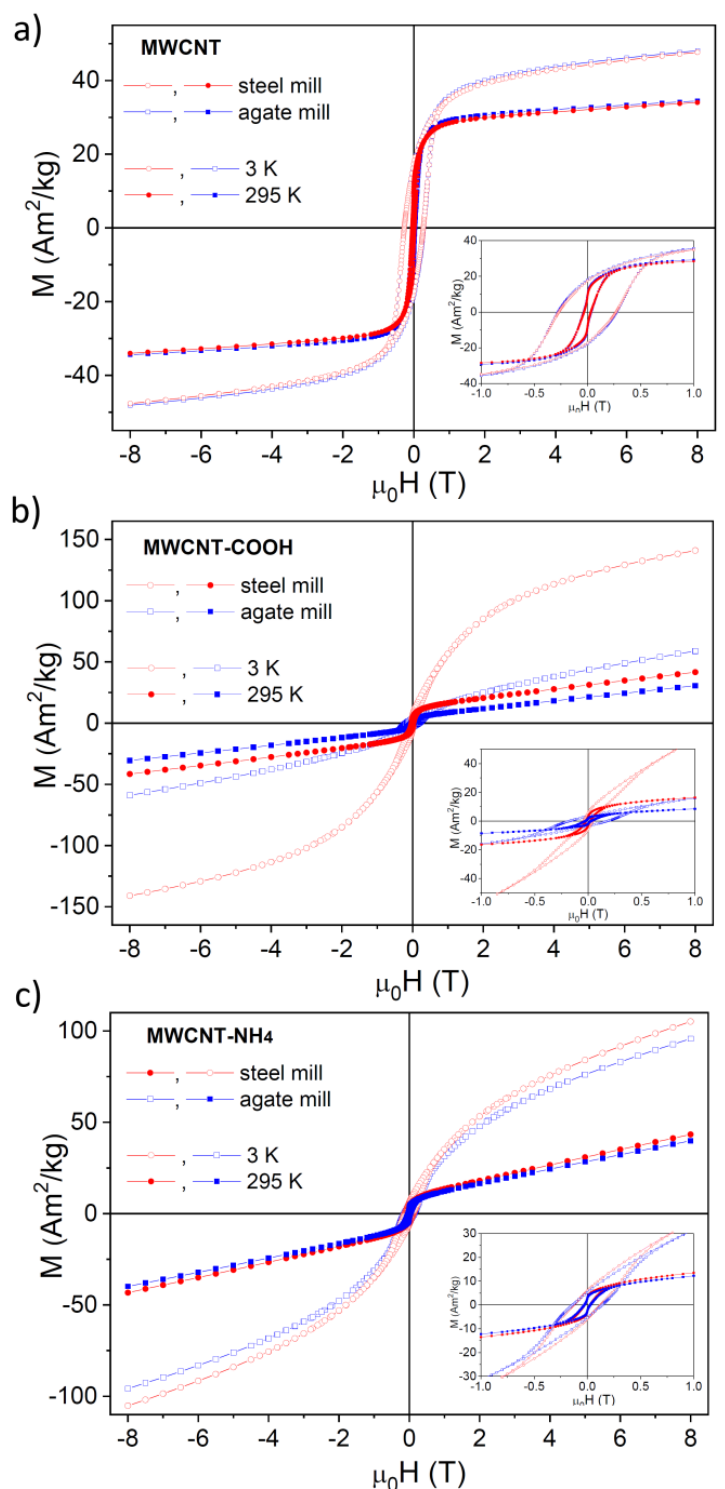
Figure 5. Field dependencies of magnetization (M) for ( a ) as prepared MWCNTs, ( b ) MWCNTs-COOH, and ( c ) MWCNTs-COONH 4 obtained from MWCNTs prepared in the agate (blue squares) and steel (red circles) mill. Empty symbols denote the data measured at 3 K, and full symbols correspond to the data measured at 295 K. The insets show the expansion of the dependencies close to the